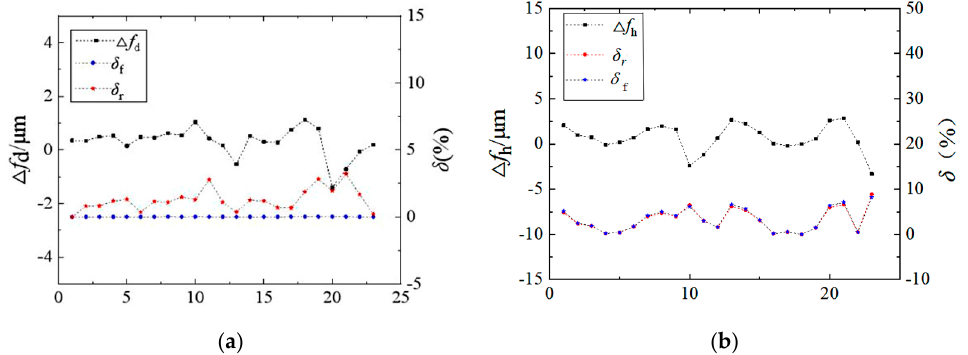
Figure 10. Comparison of processing results of off-axis detection method. ( a ) Radius values at 4° declination. ( b ) Value of vector height at 4° declination angle.